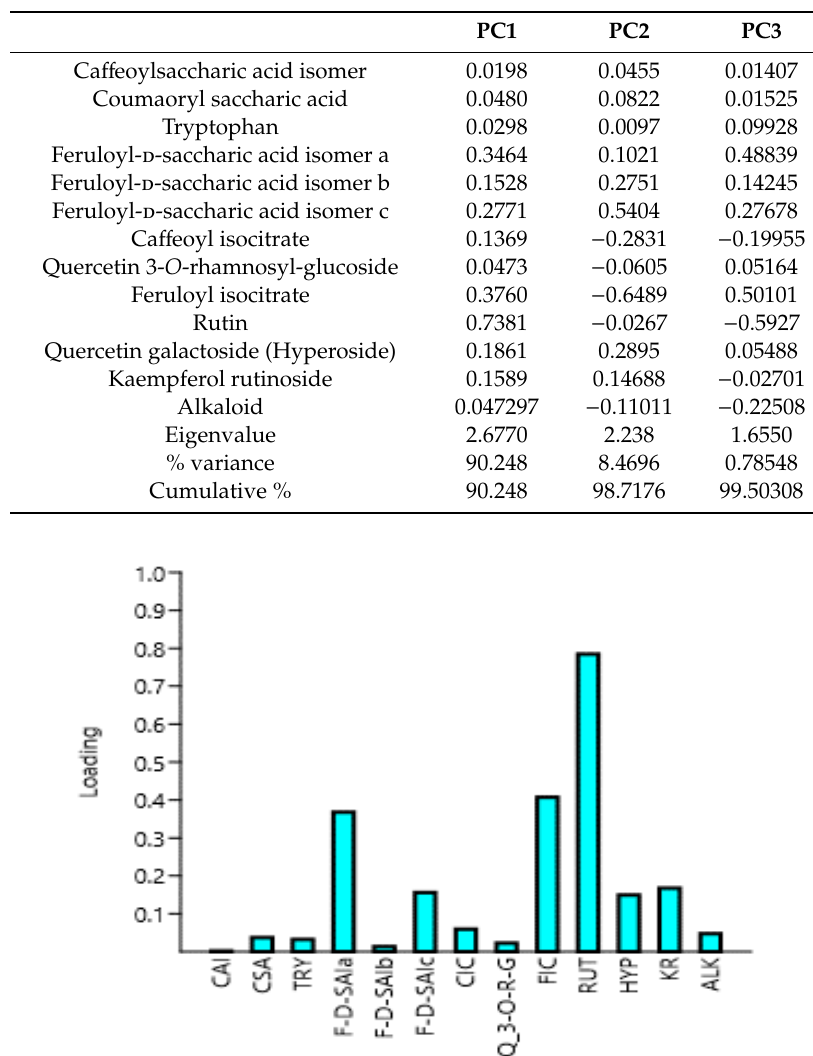
Table 3. Principal component analysis of the phenolic compounds in the amaranth plant, showing their percentage contribution to the total variations.